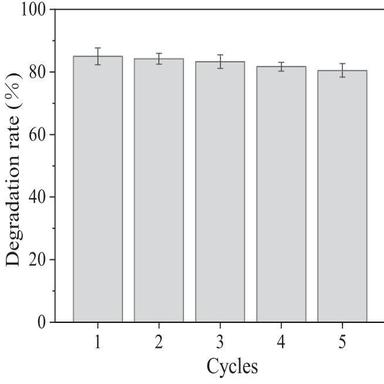
NAs oxidative degradation in five consecutive cycles by CO2-responsive phase transfer materials. Conditions:C0 (NAs) = 0.5 mmol⋅L− 1 ; C0 (sodium persulfate) = 40 mM; C0 (CO2-responsive phase transfer materials) = 0.2 g.